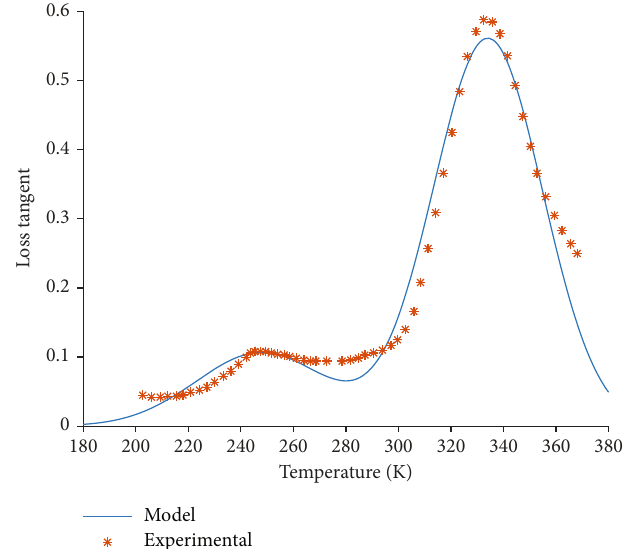
Figure 9: Prediction results for 10Hz loss tangent with corrected values of N and k .